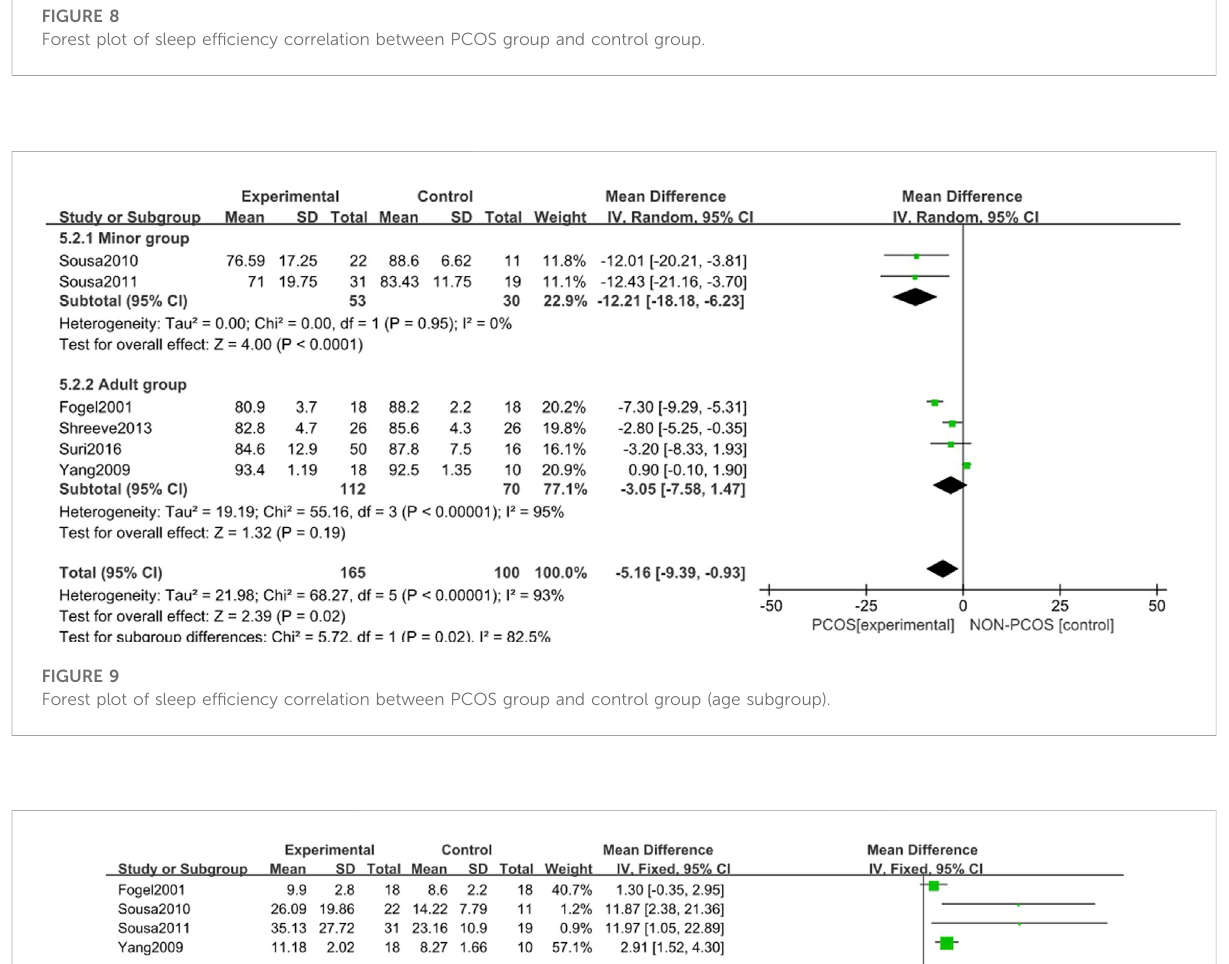
FIGURE 10 Forest plot of correlation between sleep onset latency in PCOS group and control